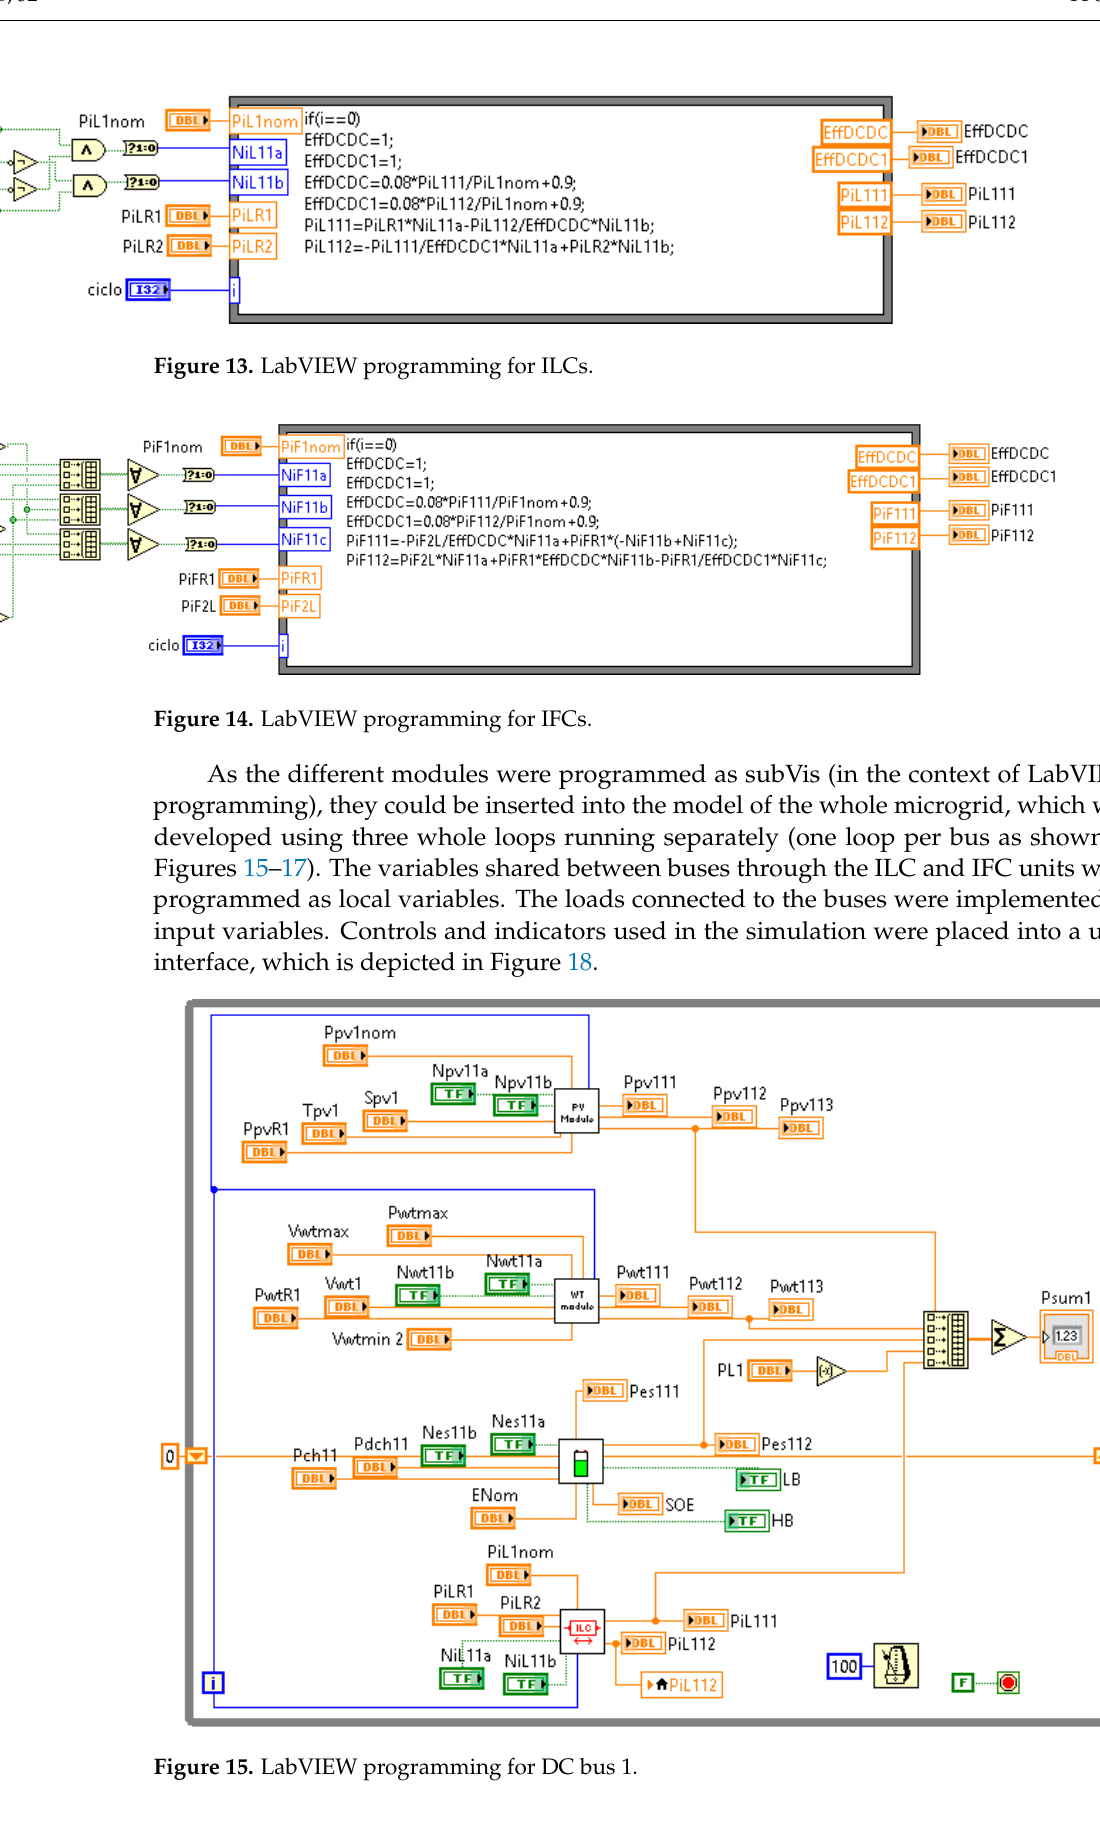
Figure 15. LabVIEW programming for DC bus 1.